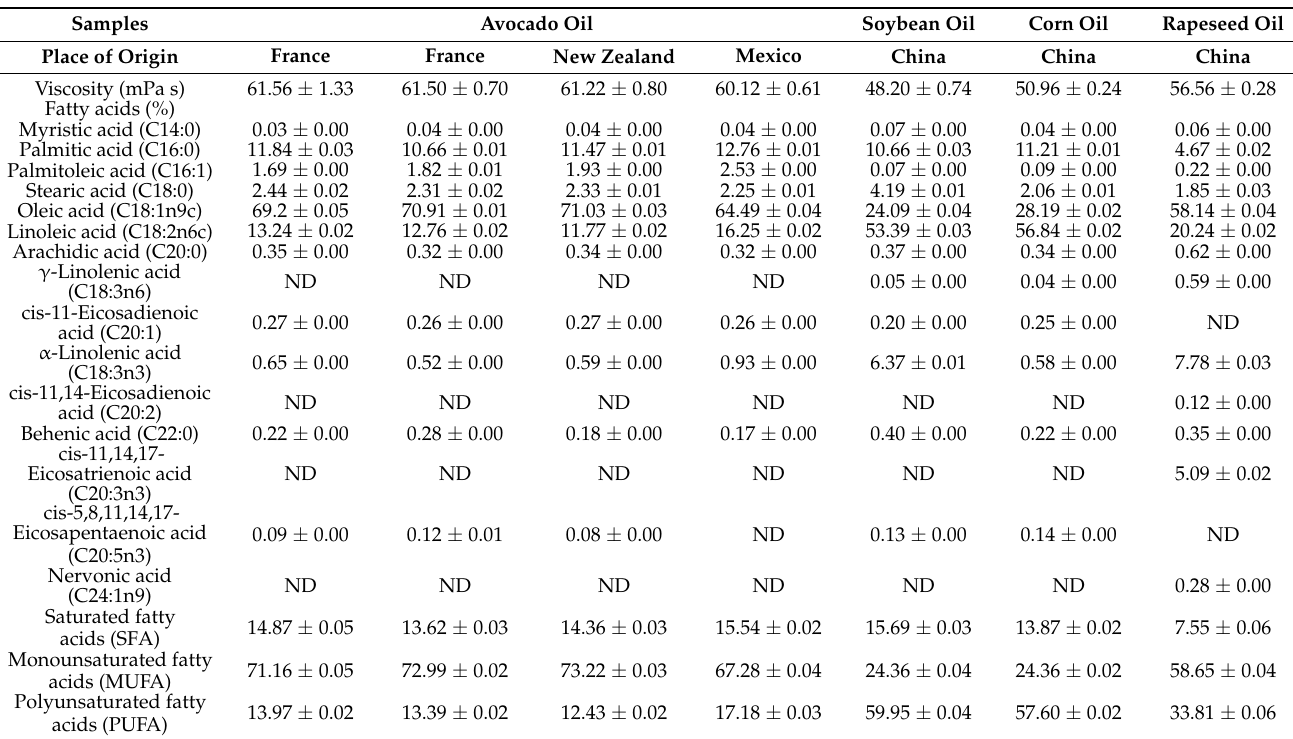
Table 3. Fatty acid composition and viscosity of pure AO, SO, CO and